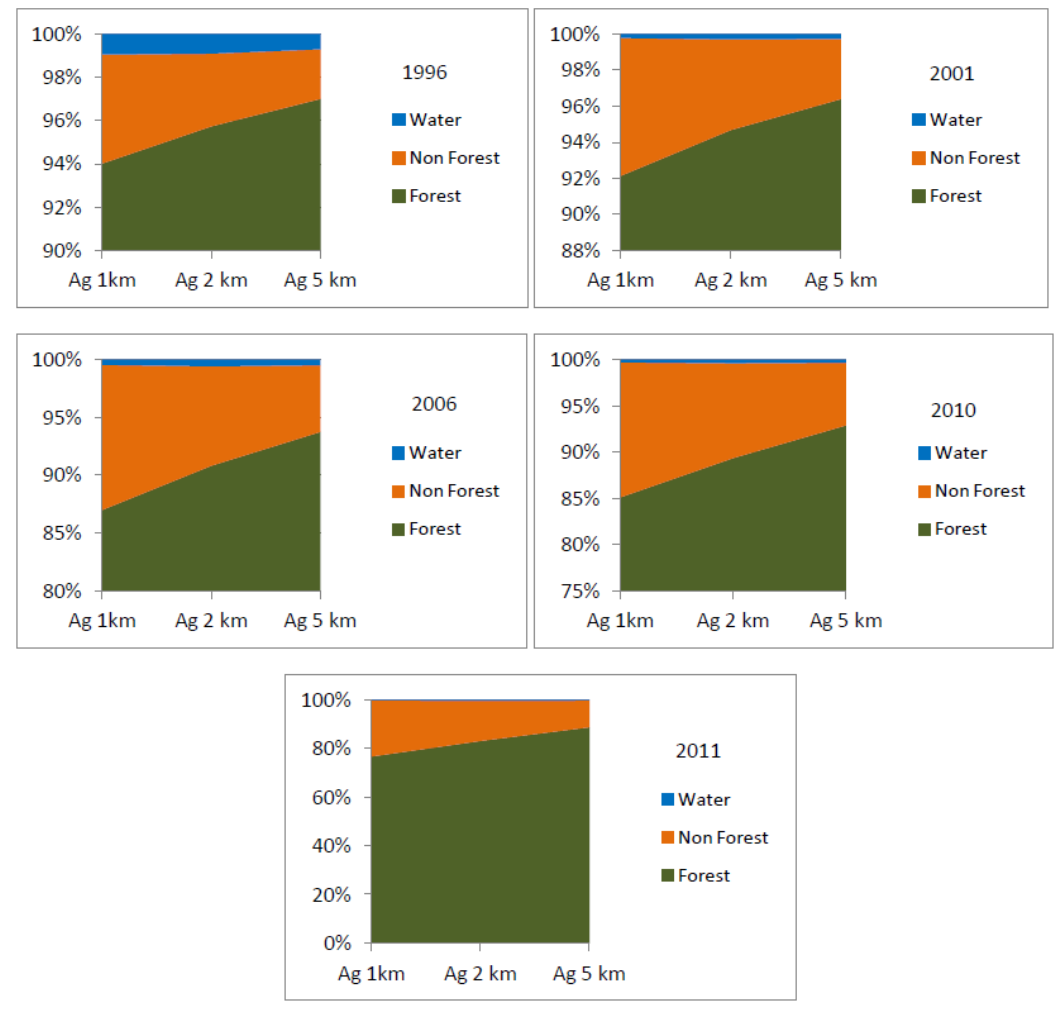
Figure 6. Forest, non-forest and water land-cover change dynamic of 1 km, 2 km, and 5 km road buffer within agricultural titled land for 1996, 2001, 2006, 2011 for the Province of